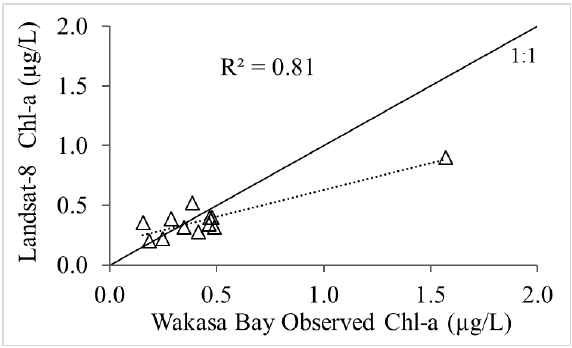
Figure 6. Observed and Landsat-8 derived chlorophyll-a for Wakasa Bay (3 August 2018).